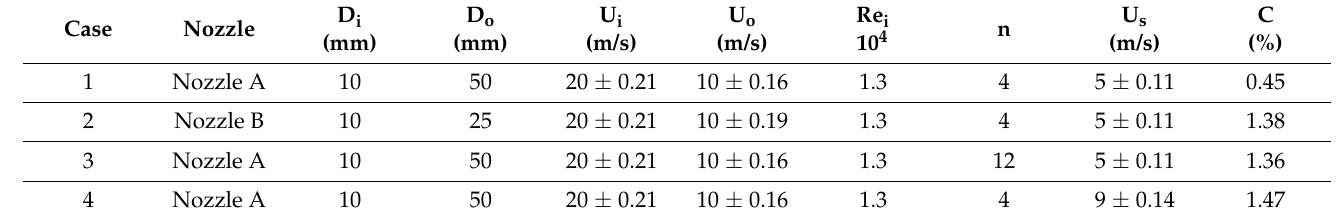
Table 1. Parameters of nozzles and synthetic jet actuators.